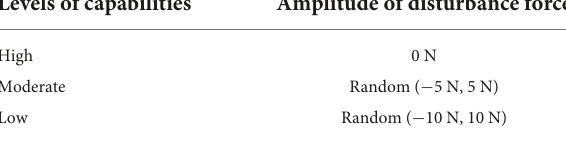
TABLE 2 The design of three typed of disturbance